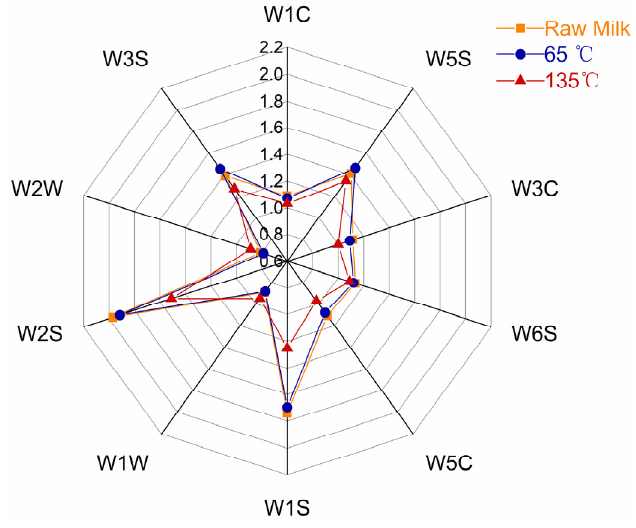
Figure 2. Radar map of VOCs in milk processed using different temperatures.